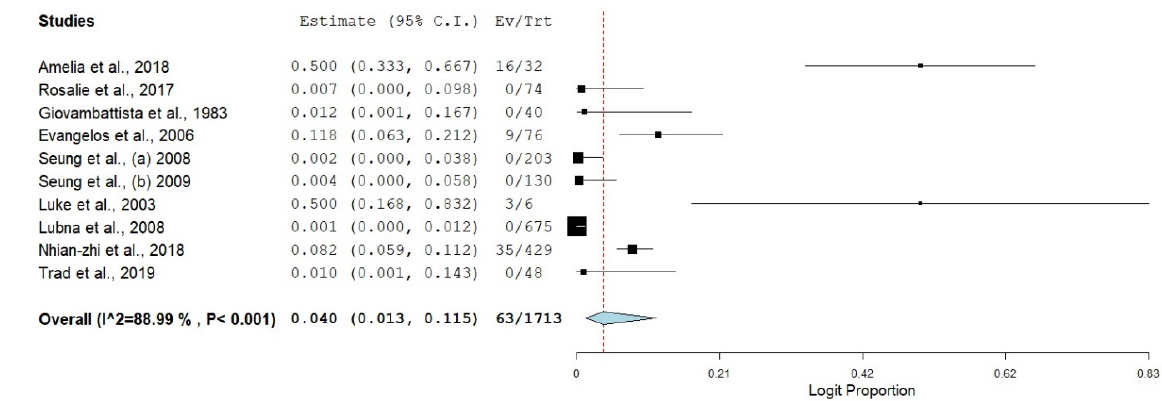
Figure 4. Funnel plot showing publication bias for SBP in HBV cirrhosis (Egger’s p = 0.01273).